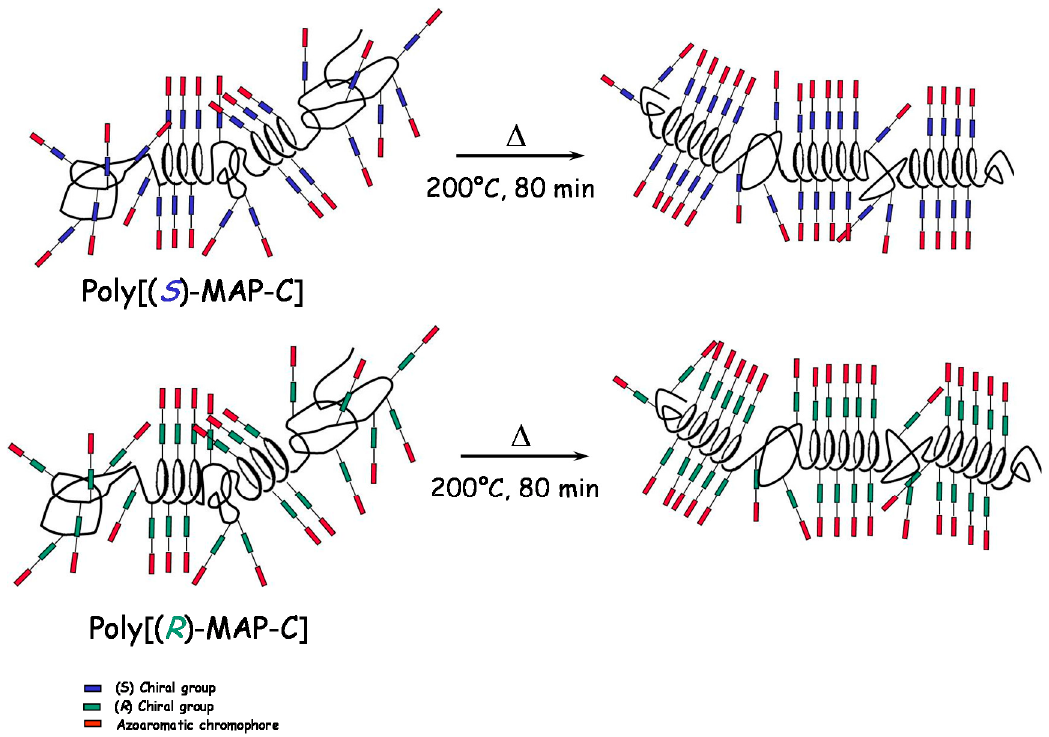
Figure 6. Idealized pictures of thermoinduced conformational chiral order of the macromolecules.